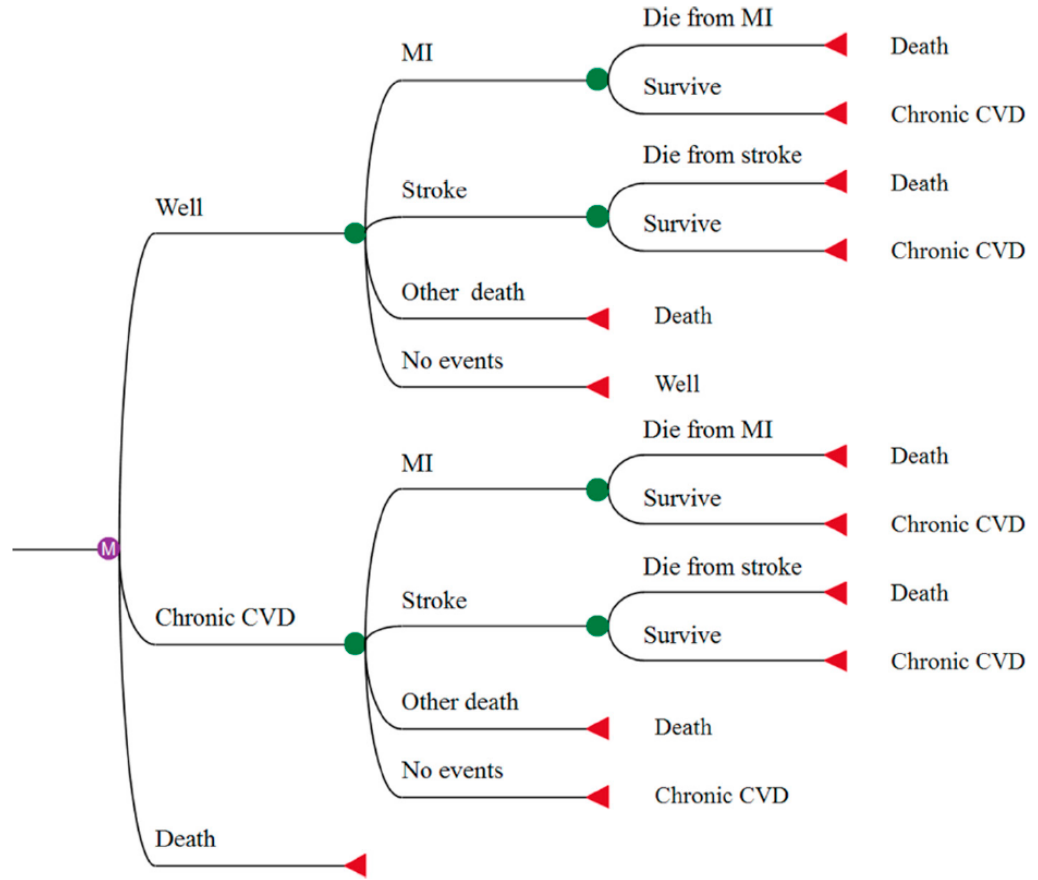
Figure 1. Decision tree representation of one branch of the Markov model structure for each arm. The model was based on the structure of Li [27]. The “well” and “chronic cardiovascular disease (CVD)” states are populated by individuals without and with prior myocardial infarction (MI) or stroke, respectively. The initial distribution of the population was set as follows: 3.83% of the individuals started in the “chronic CVD” state, and the remaining 96.17% started from the “well” state [28]. Individuals in the “well” state can remain in their state or progress to “chronic CVD” in the case of a first-ever MI or stroke. In each cycle, individuals in the “well” and the “chronic CVD” states may experience an MI or stroke and are characterized by the same survival probabilities as other individuals in their state, regardless of their medical history. “Other death” accounts for all individuals who die of causes that differ from CVDs.